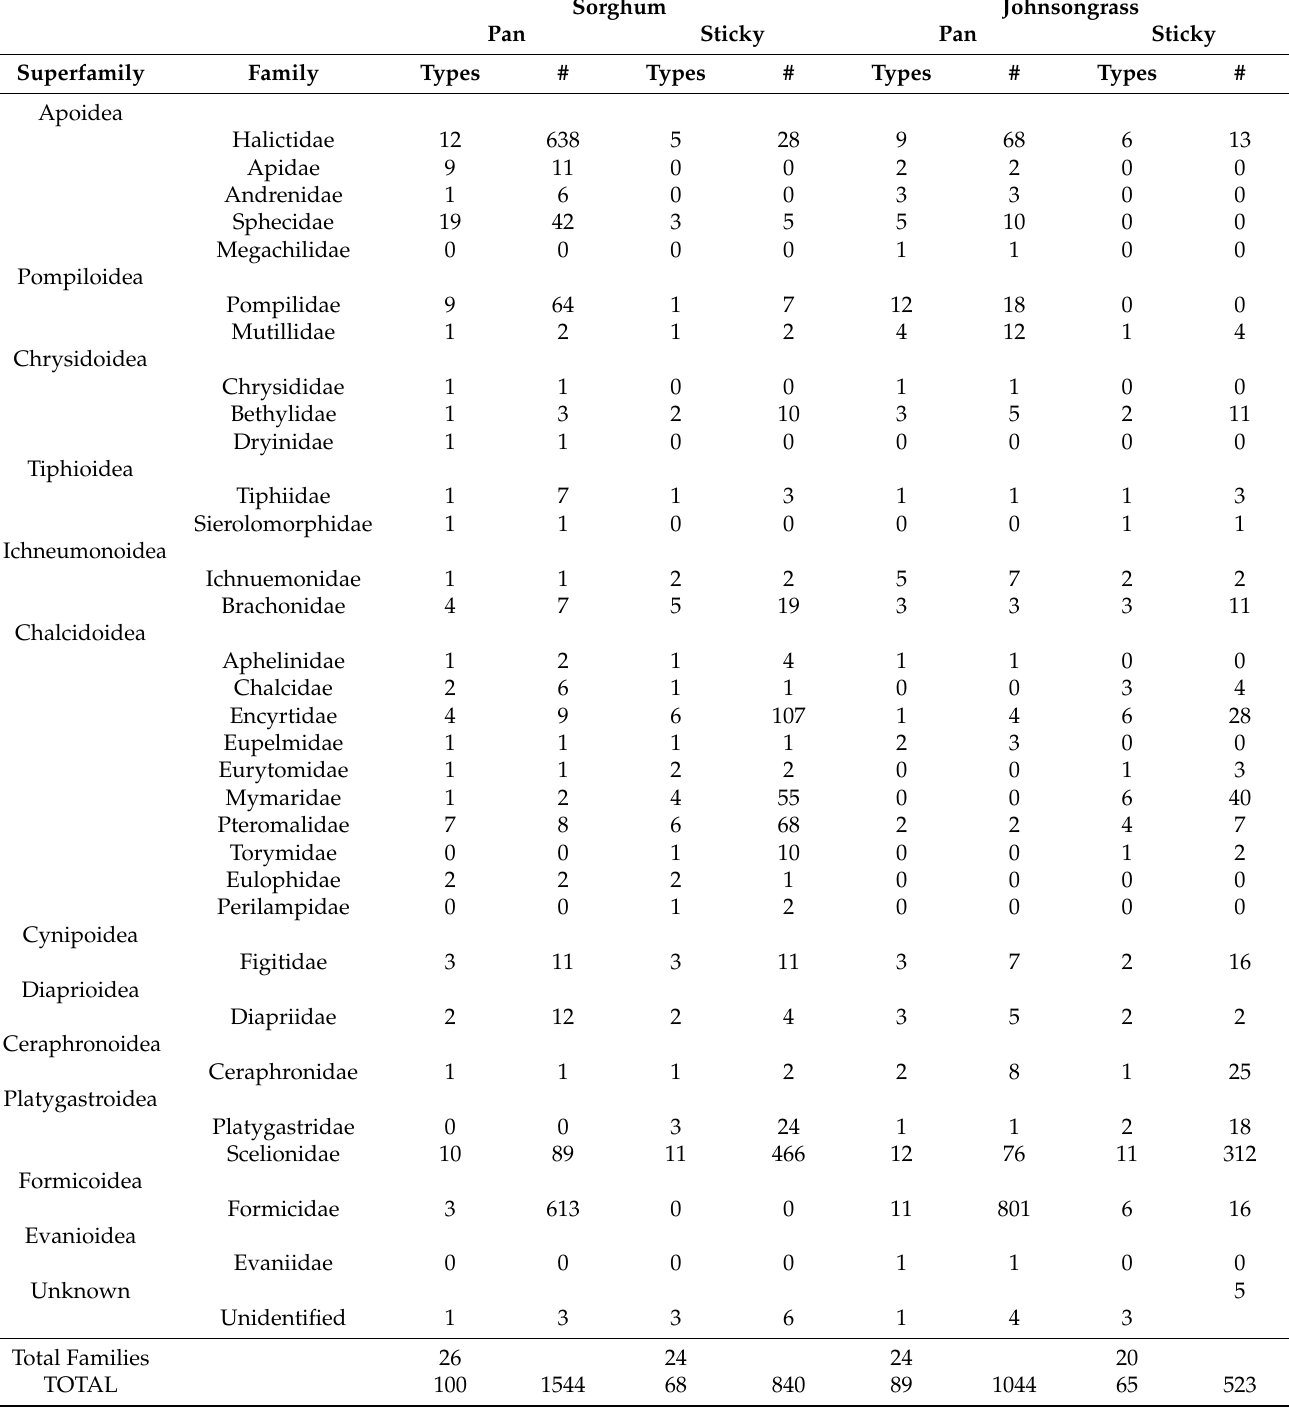
Table 4. Comparison of trapping method in sorghum and